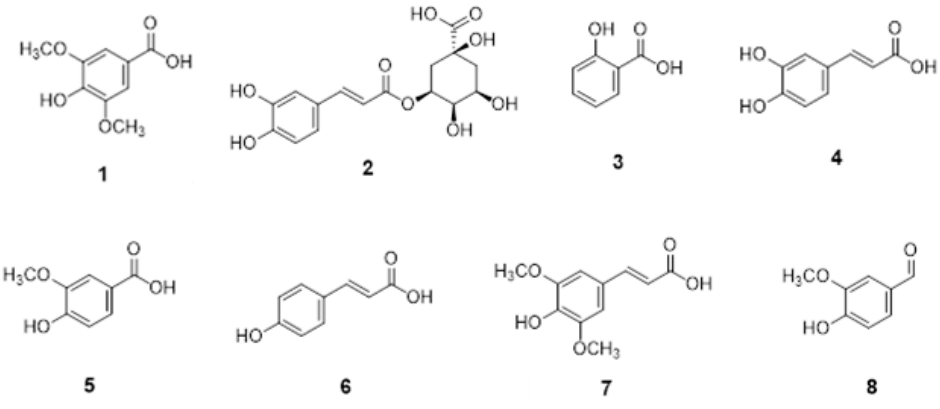
Figure 2. Chemical structures of the main phenolic acids identified in the L. barbarum leaf extract. 1: syringic acid; 2: chlorogenic acid; 3: salicylic acid; 4: caffeic acid; 5: vanillic acid; 6: p ‐ coumaric acid; 7: sinapic acid; 8: vanillin. Table 1. Phenolic acid content ( µ g / g ± SD) of L. barbarum leaf extract. n.